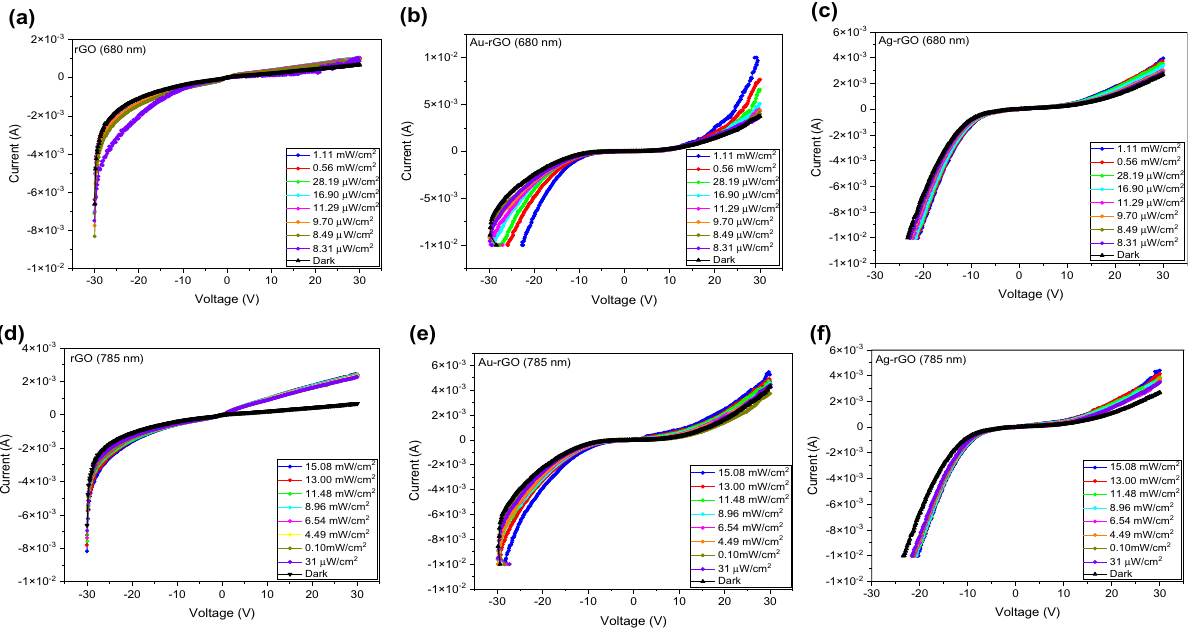
Figure 4. I–V characteristics of bare rGO, Au-rGO and Ag-rGO PD at different power between ( a – c ) 8.31 µW cm −2 to 1.11 mW cm −2 under laser irradiation of 680 nm. ( d – f ): 31 µW cm −2 to 15.08 mW cm −2 under laser irradiation of 785 nm.